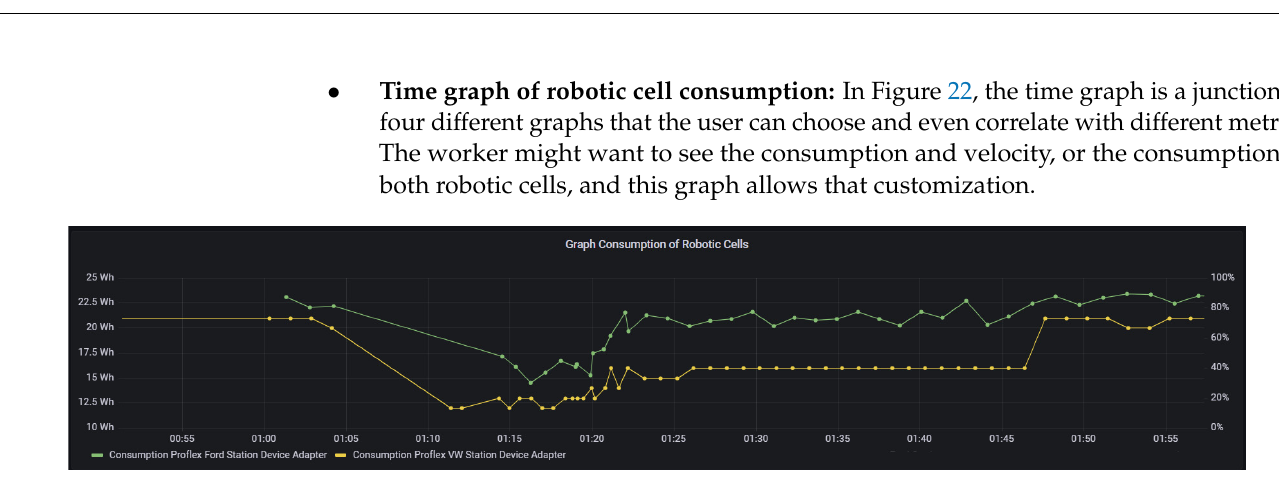
Figure 21. Energy/Velocity histogram panel, the ( a ) and ( b ) the energy consumption for Ford and VW respectively and the ( c ) and ( d ) the percentage velocity for Ford and VW respectively.